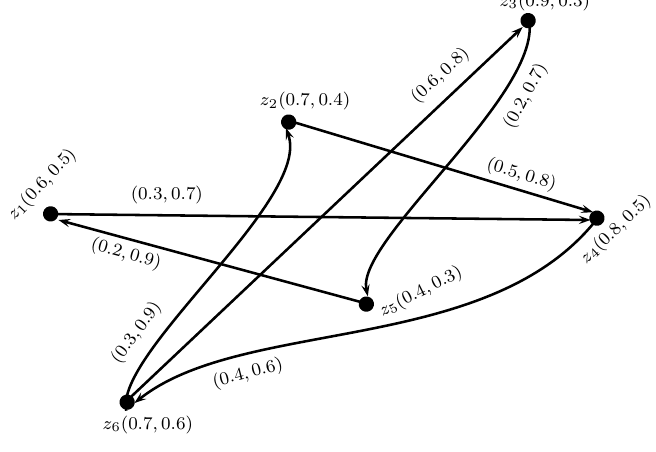
Figure 4. Pythagorean fuzzy